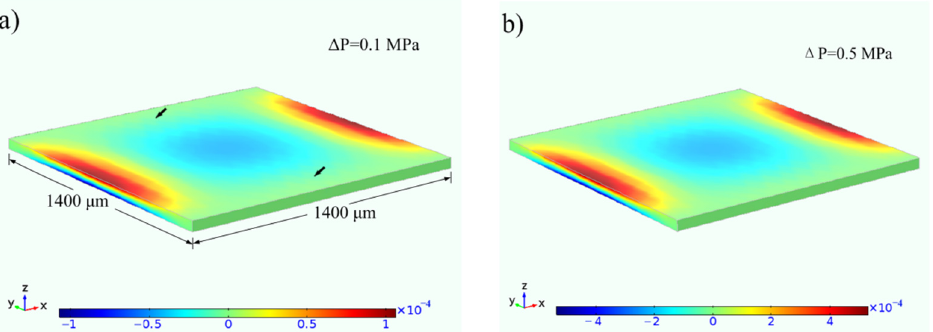
ε Figure 4. Simulative strain fields for cavity membrane: ( a ) strain ε xx distribution under the differential Figure 4. Simulative strain fields for cavity membrane: ( a ) strain xx distribution under the differ- pressure with 0.1 MPa; ( b ) ε xx distribution under differential pressure with 0.5 ε ential pressure with 0.1 MPa; ( b ) xx distribution under differential pressure with 0.5 MPa.